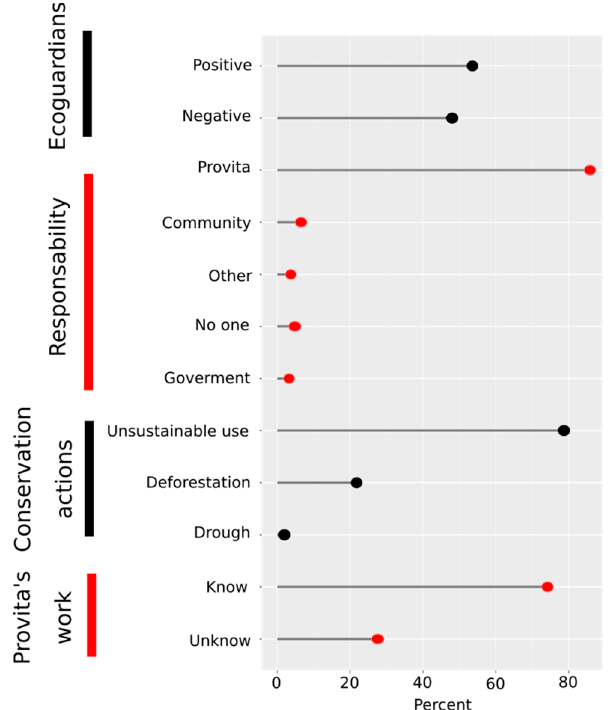
Figure 3. Acceptability of conservation management in three communities of the Macanao Peninsula regarding the yellow ‐ shouldered Amazon Conservation Program.